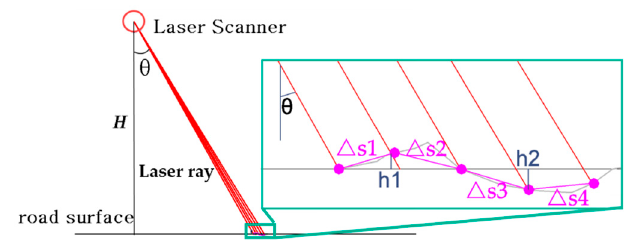
Figure 4. Distribution of laser foot points on the ground.